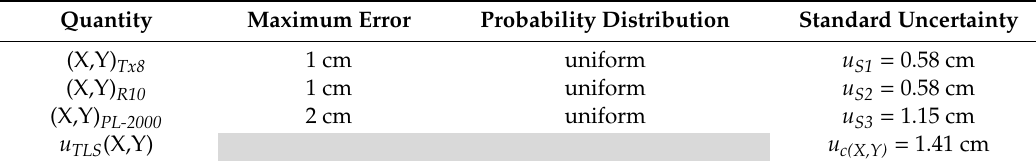
Table 1. Uncertainty budget (X or Y coordinate) of TLS system.